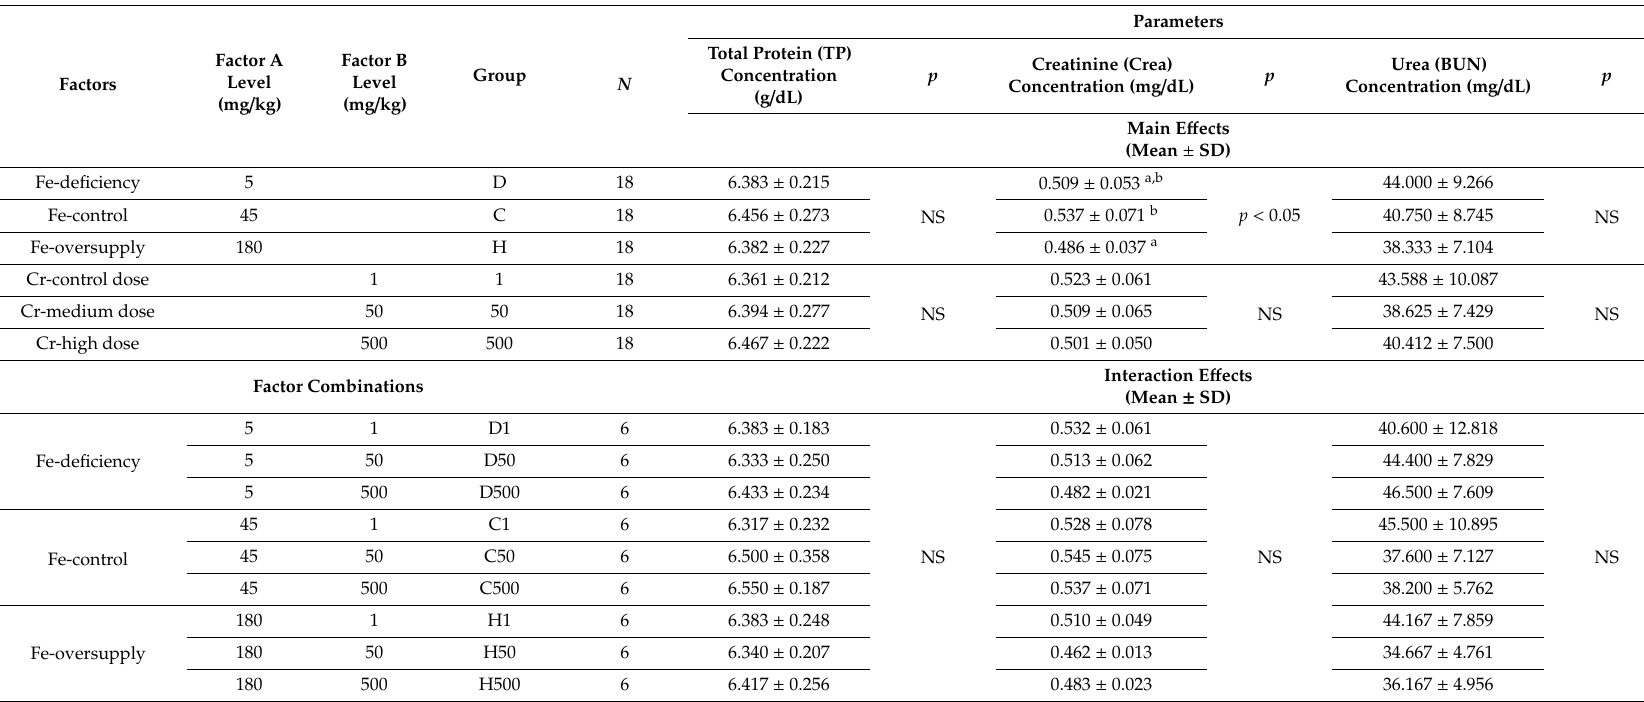
Table 5. The e ff ects of the Fe(III) and Cr(III) levels in the diet on the concentrations of selected biochemical parameters in